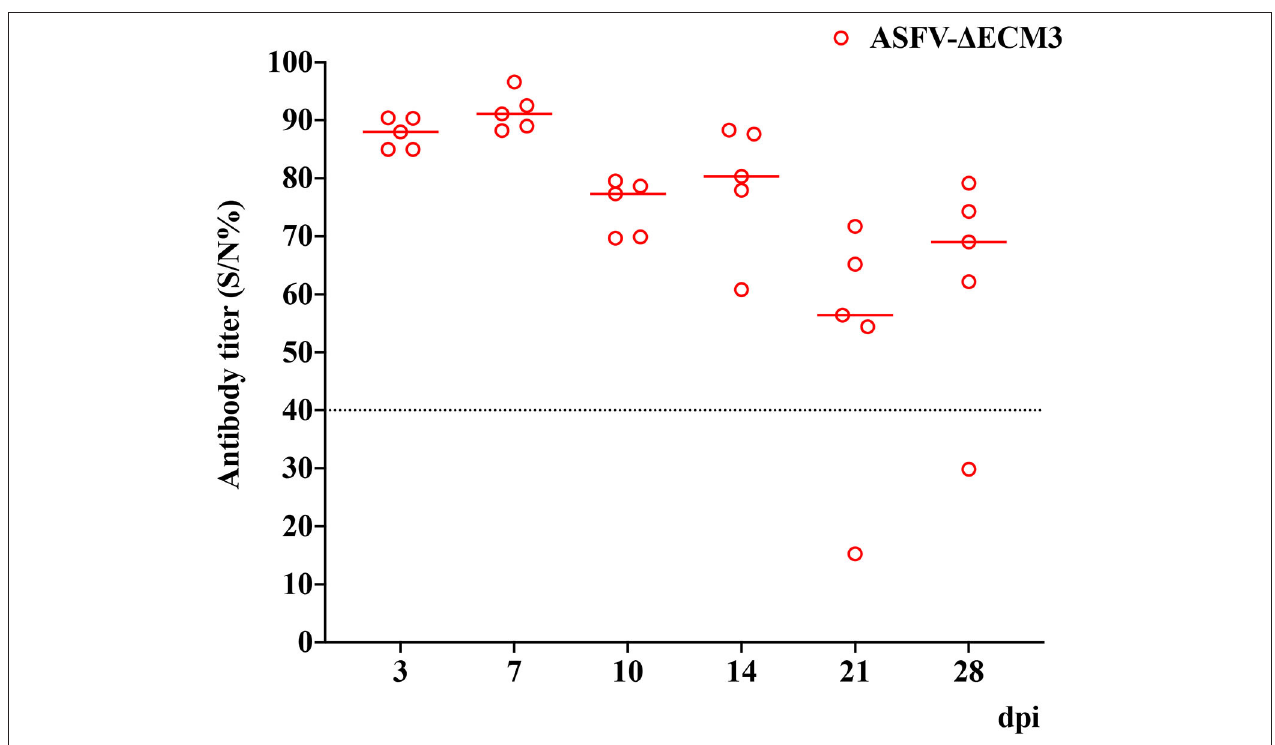
FIGURE 7 | Detection of antibodies against ASFV in sera of pigs. Serum levels of ASFV-specific antibodies were measured using the African Swine Fever Competition ELISA kits. Positive: S/N% ≤ 40%. Doubtful: 40% < S/N% < 50%. Negative: S/N% ≥ 50%.